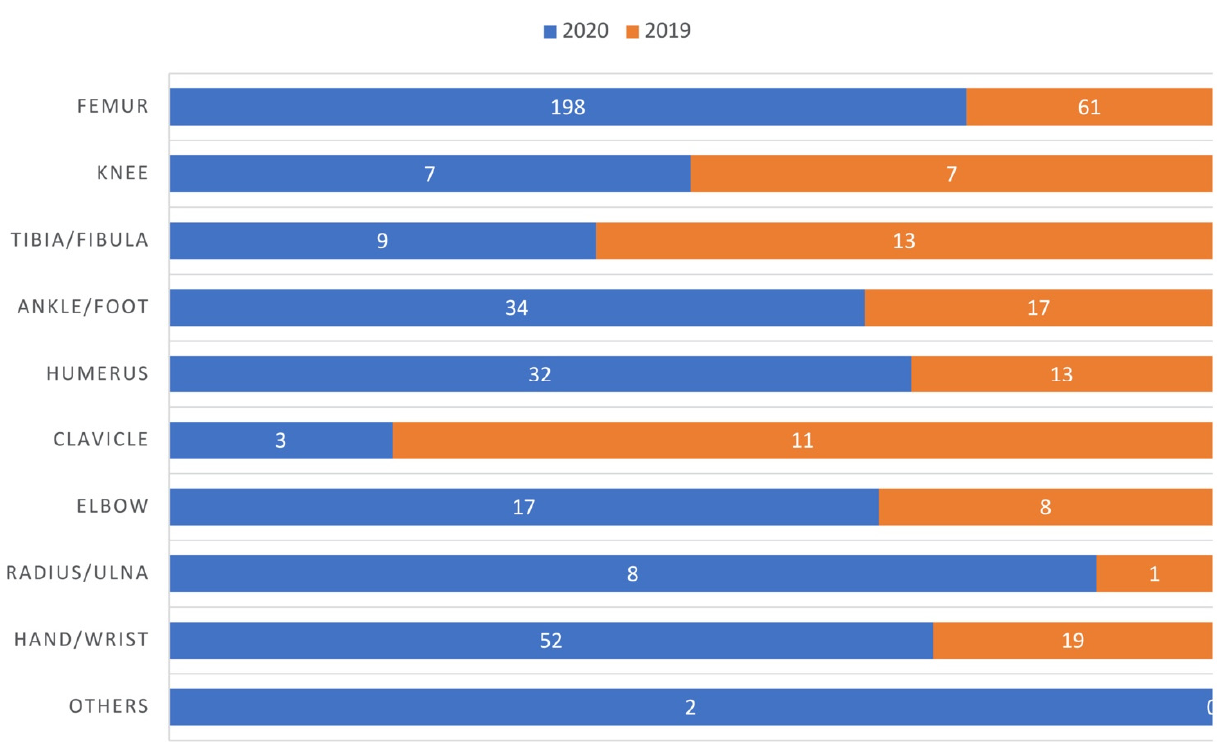
Figure 1. Typification of fractures. Femoral fractures were significantly more frequent in 2020 ( p -value = 0.0137).